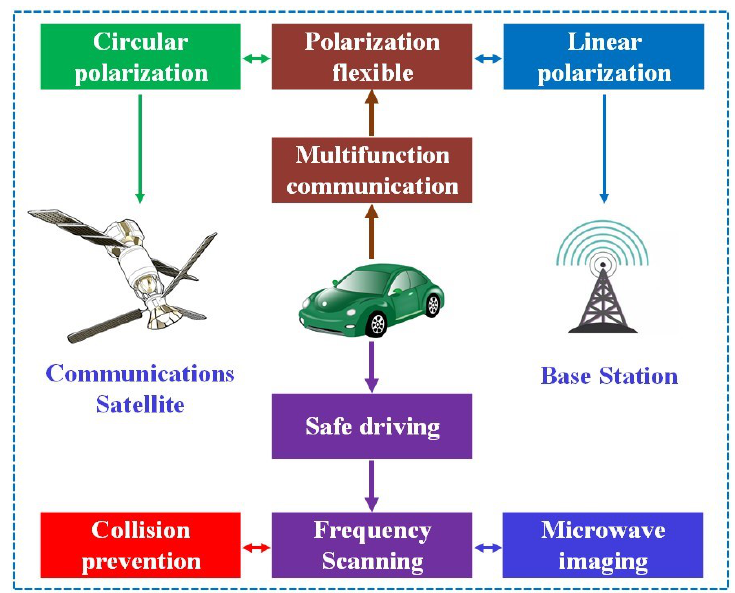
Figure 1. The performance diagram of the required